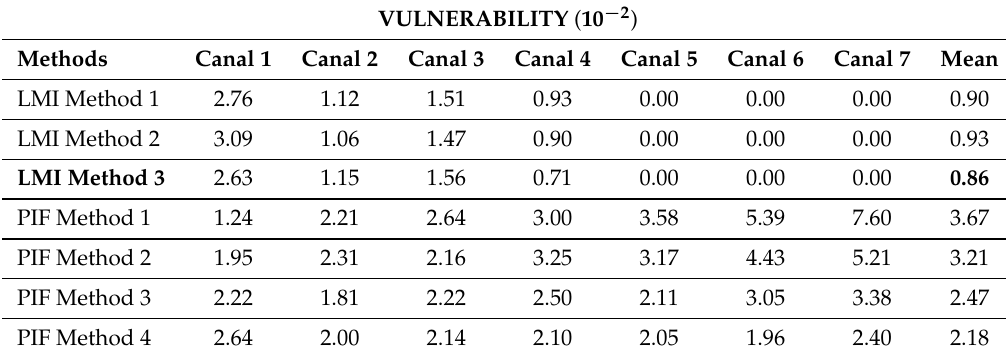
Table 5. Non-linear model simulation KPIs: